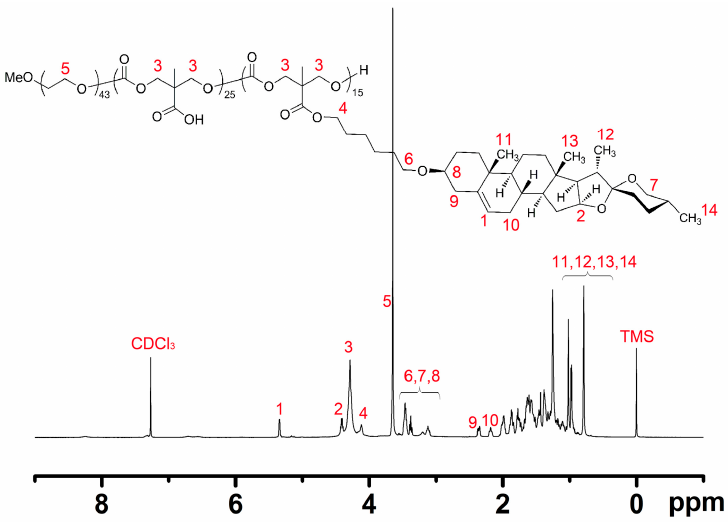
Figure 1. 1 H NMR spectra of mPEG 43 -PMCC 25 -P(MCC-DHO) 15 .